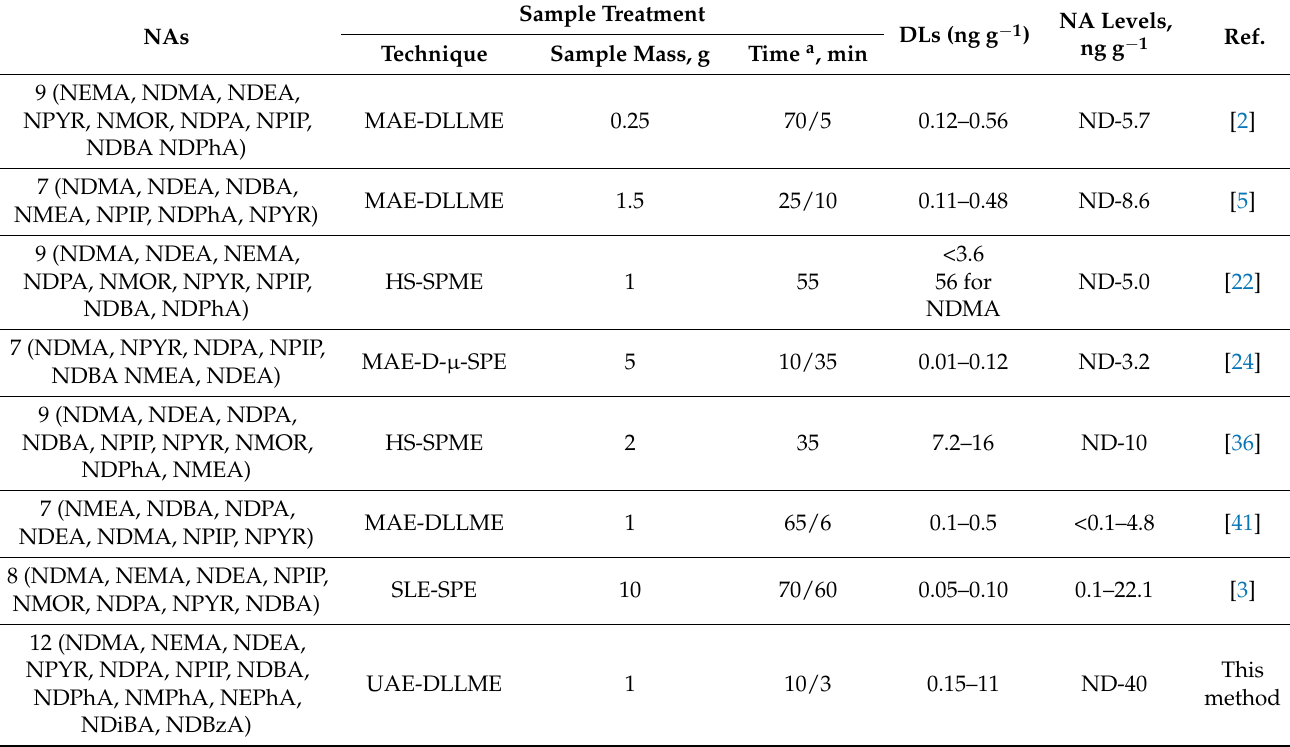
Table 3. Comparison of the proposed method with others previously published for NA quantification in meat by GC–MS. Sample NAs